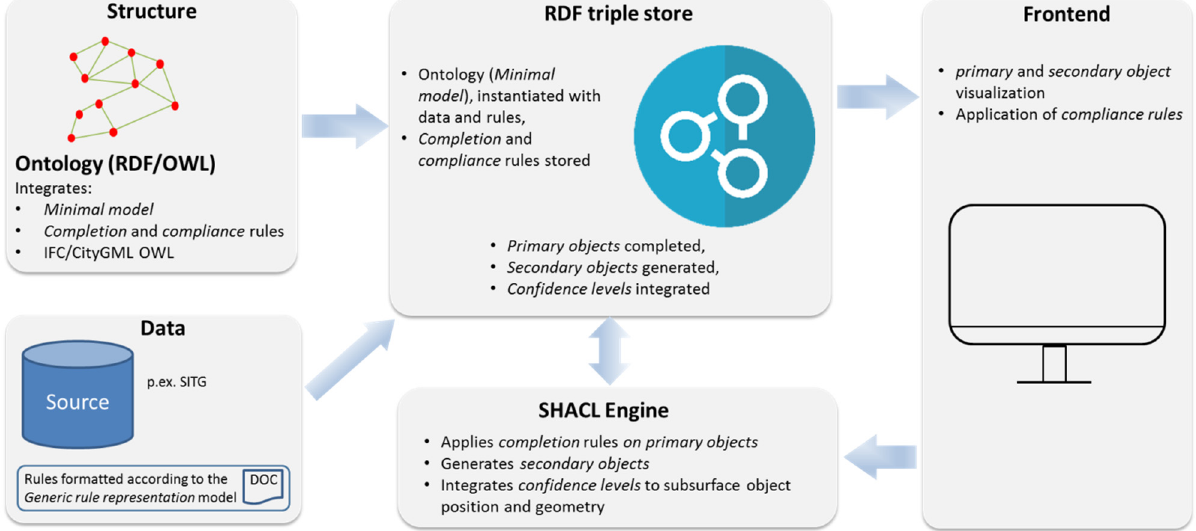
Figure 1. Subsurface global workflow.